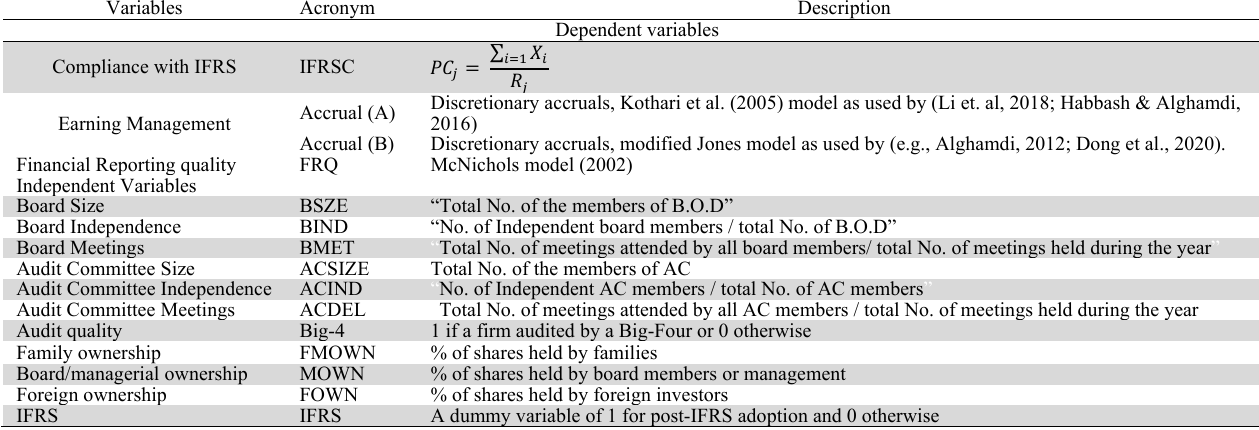
Operational Definition of